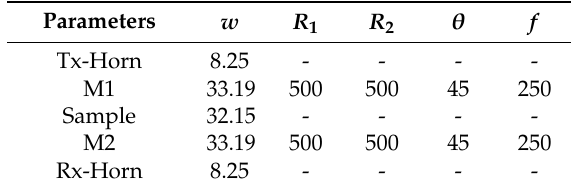
Table 1. Key parameters for the Quasi-Optical System, Frequency 90 GHz.